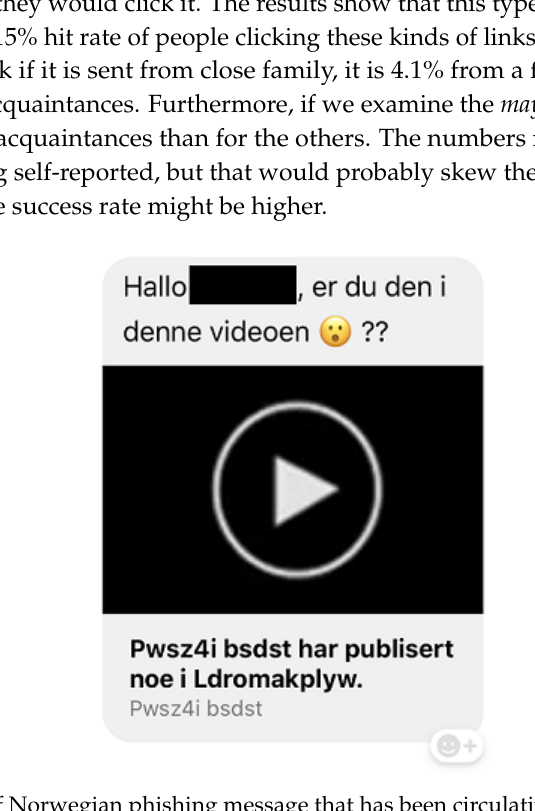
Figure 9. Example of Norwegian phishing message that has been circulating from hacked Facebook accounts and sent to people on their friends list. Table 21. Who the respondents thought they might get tricked into clicking a link if they received it from. N =